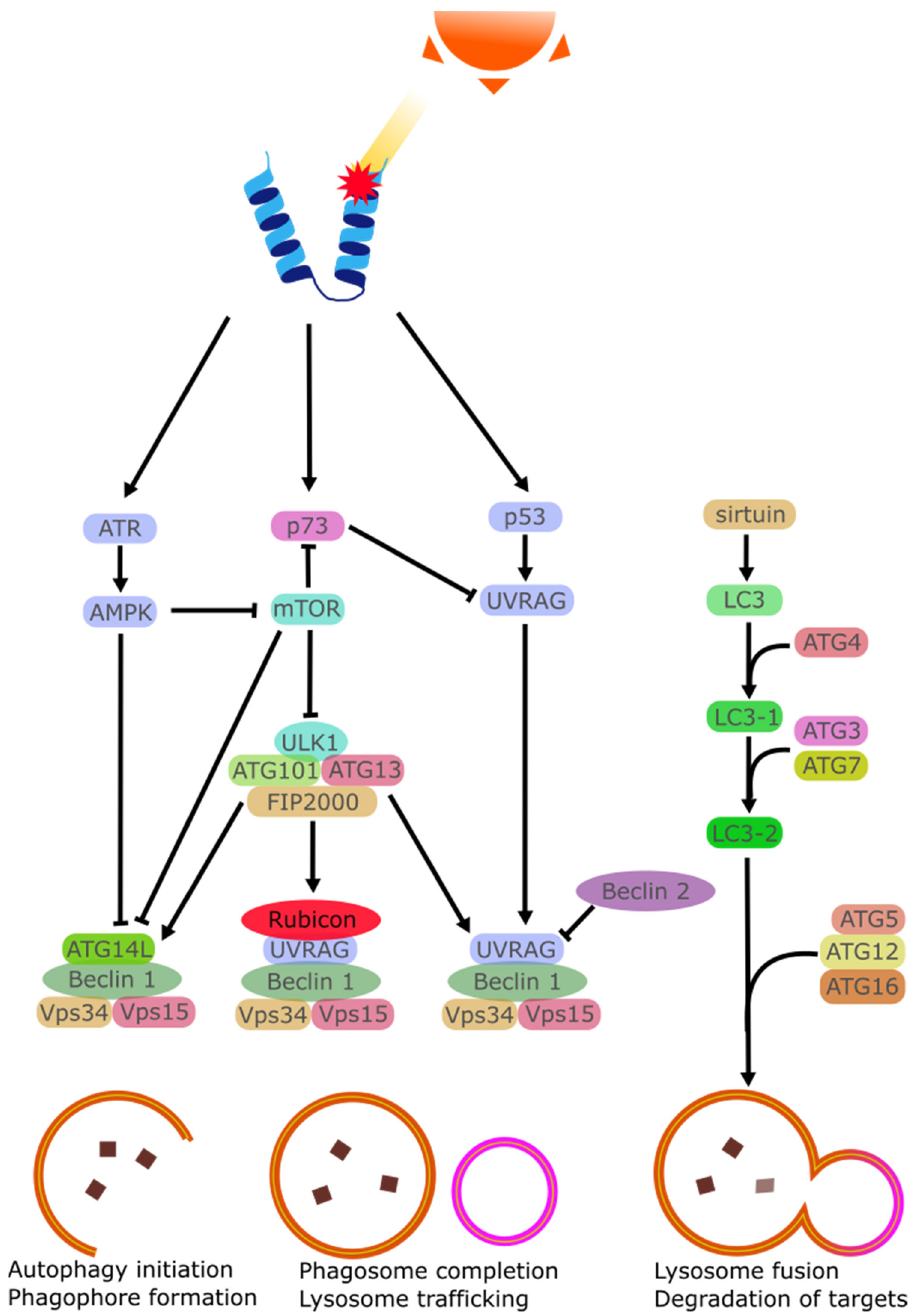
Figure 5. Simplified schematic representation of the autophagic cascade activated by UV damage of proteins.